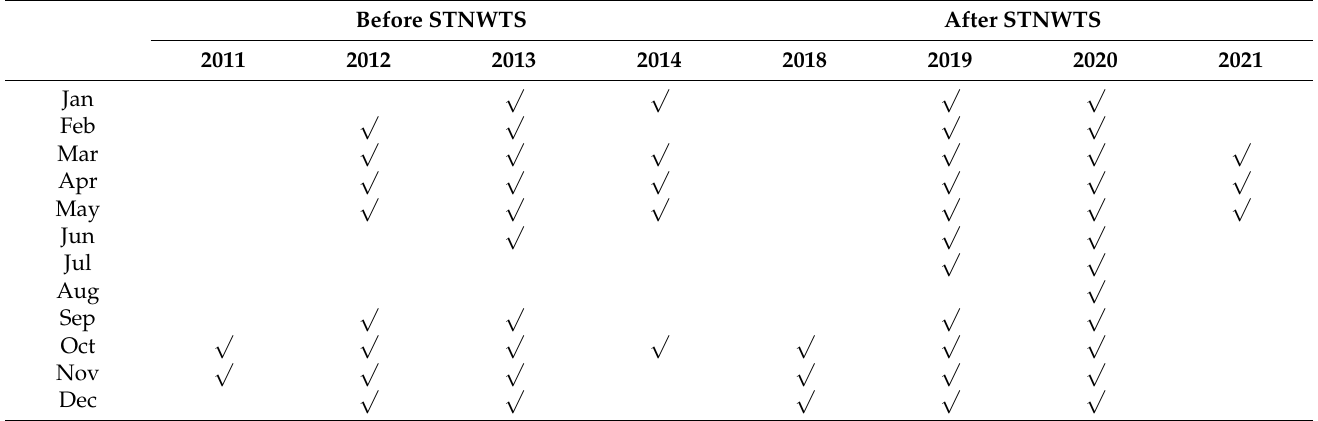
Table 1. The surveying months during each year of the two study periods. Before STNWTS After